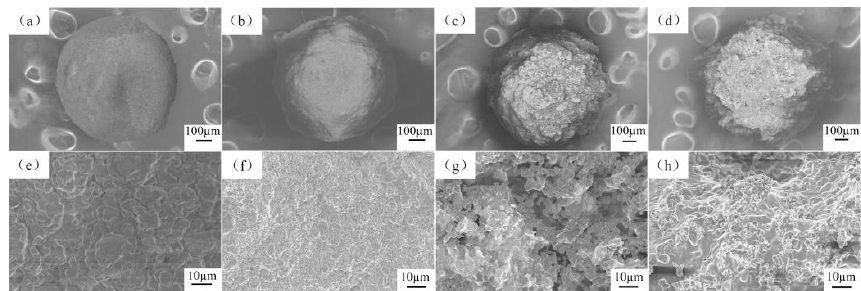
Figure 3. Scanning electron micrograph of Cu-doped HA macrobeads: ( a , e ) HA-0.1MCu, ( b , f ) HA-0.5MCu, ( c , g ) HA-1.0MCu, ( d , h ) HA-1.5MCu.